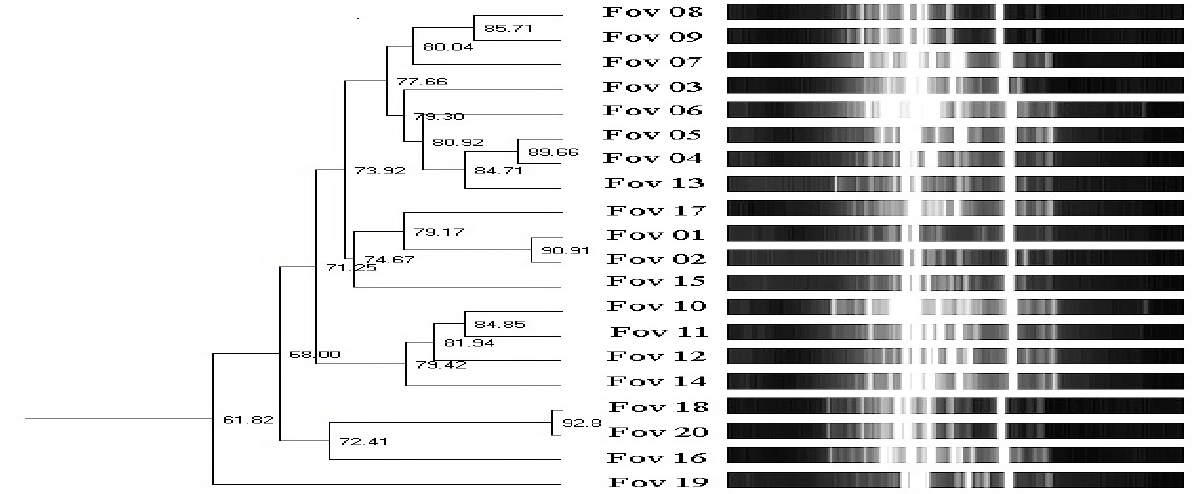
Fig. 1. Digitized UP-PCR patterns and dendrogram for 20 isolates of Fusarium oxysporum f. sp . vasinfectum (Fov) using agarose gel (2.0%) stained with ethidium bromide. The dendrograms were constructed with the UPGMA clustering